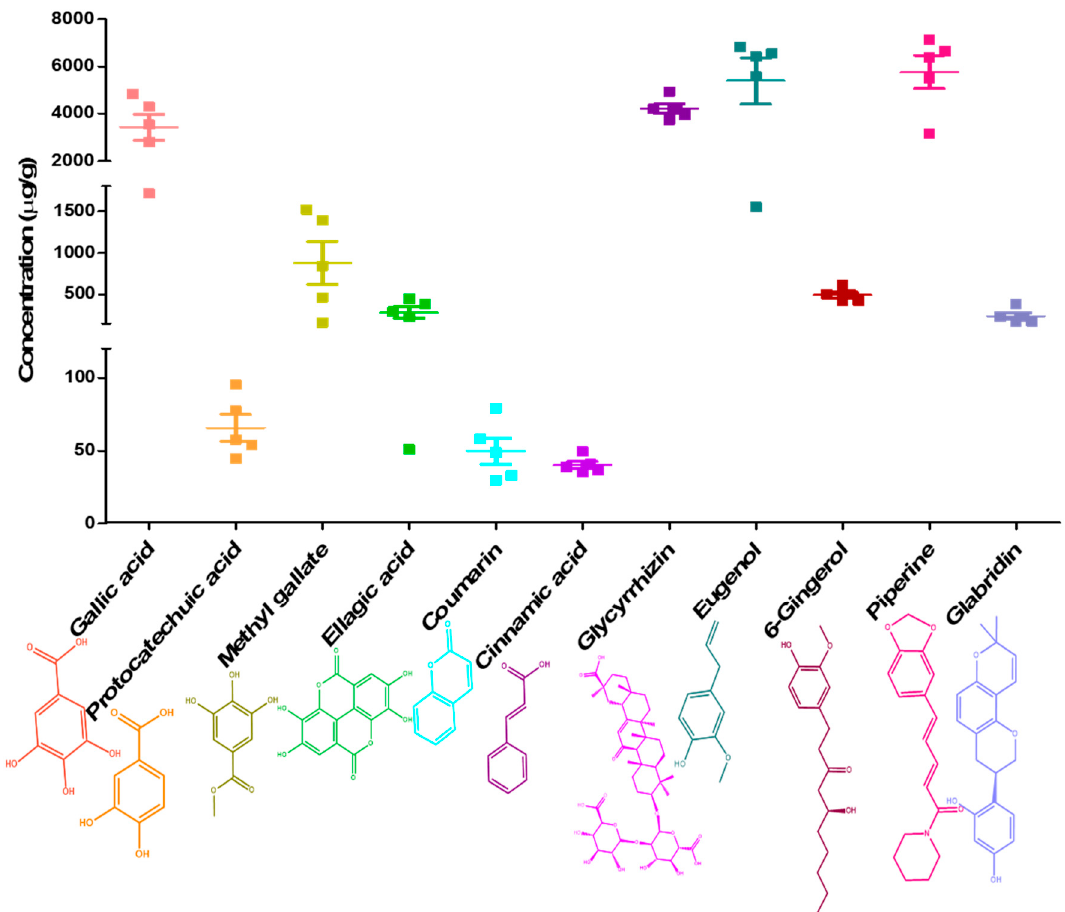
Figure 3. Quantitative analysis of gallic acid, protocatechuic acid, methyl gallate, ellagic acid, coumarin, cinnamic acid, glycyrrhzin, eugenol, 6-gingerol, piperine and glabridin using HPLC-DAD analysis in five different batches of Divya- Swasari-Vati (DSV). Scatter plot show detected concentrations of each analyte with mean and SEM ( n = 5), in DSV formulation. Chemical structure of analytes have been sourced from www.pubchem.com (accessed on 22 March 2021).